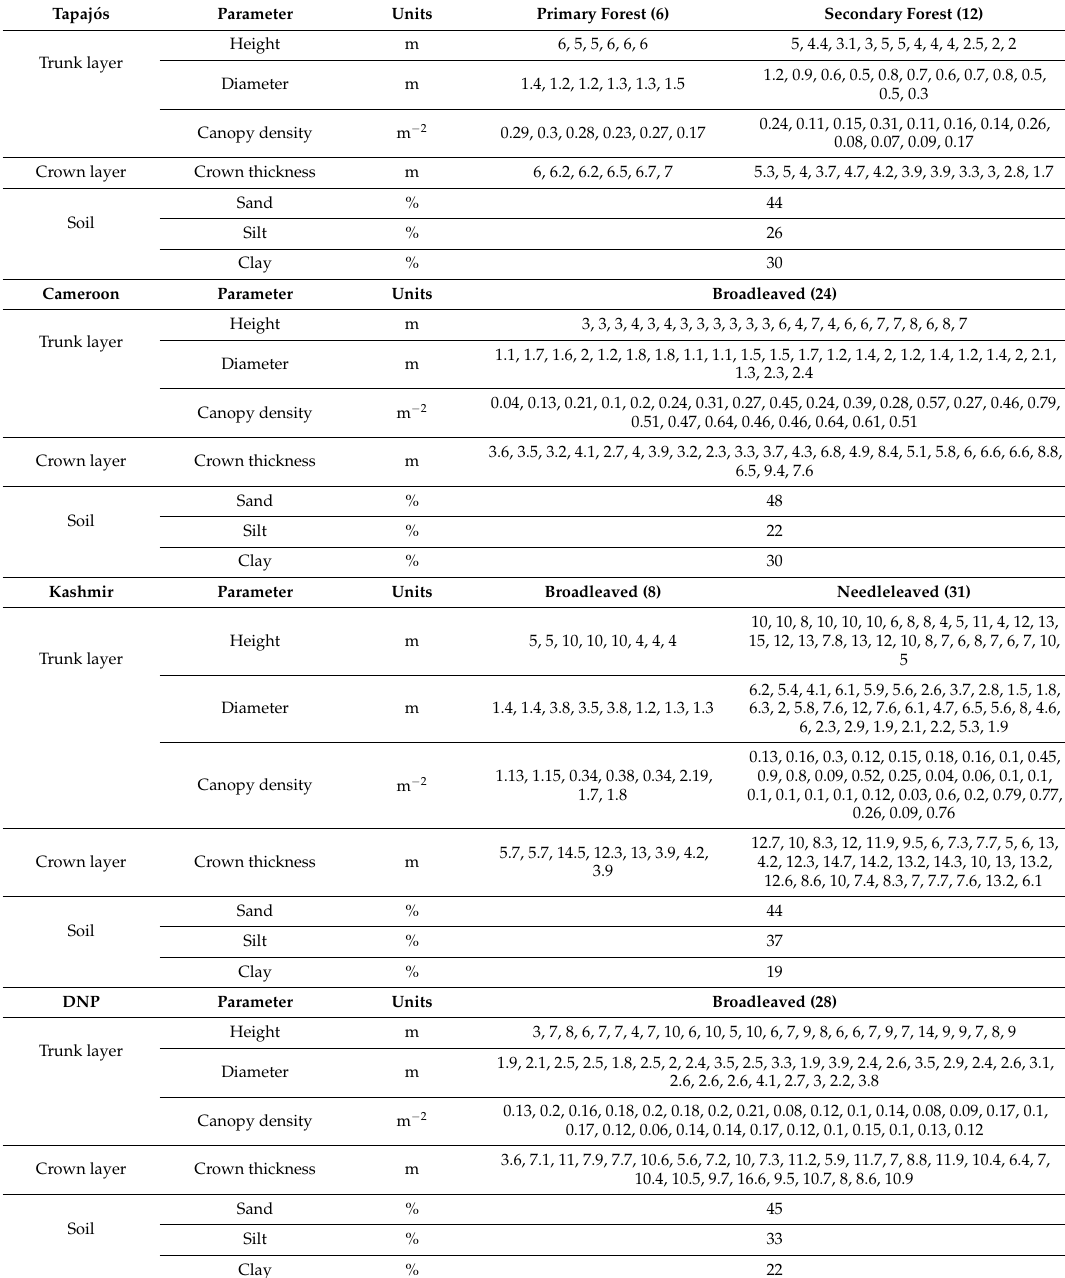
Table A1. Measured input parameters from Tapaj ó s, Cameroon, Kashmir and Dudhwa National Park (DNP) forest plots for MIMICS-I model